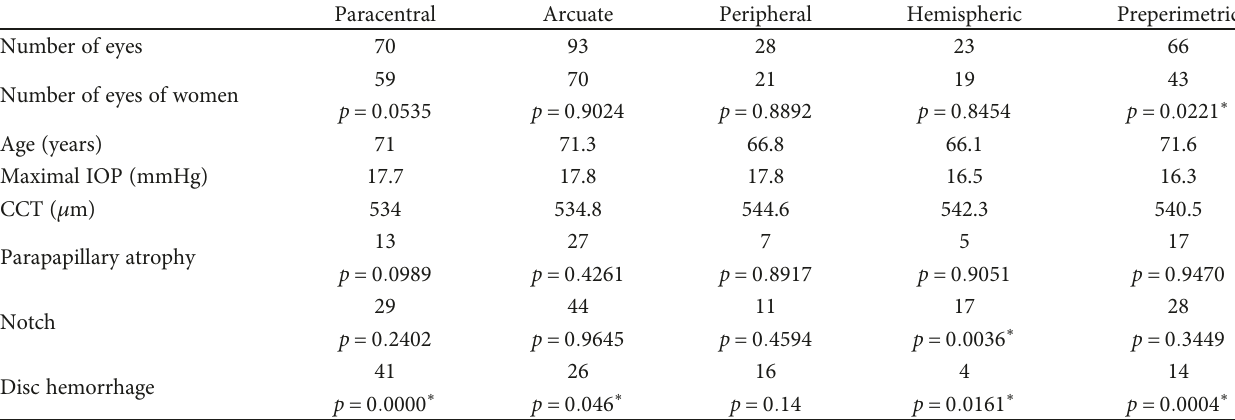
Table 2: Ocular characteristics of the subgroups of visual fi eld defects. In the table, a number of eyes were shown; a chi-square test compared if the speci fi c feature is more/less frequent in the group with speci fi c morphology of scotoma comparing to that in the rest of the studied group.